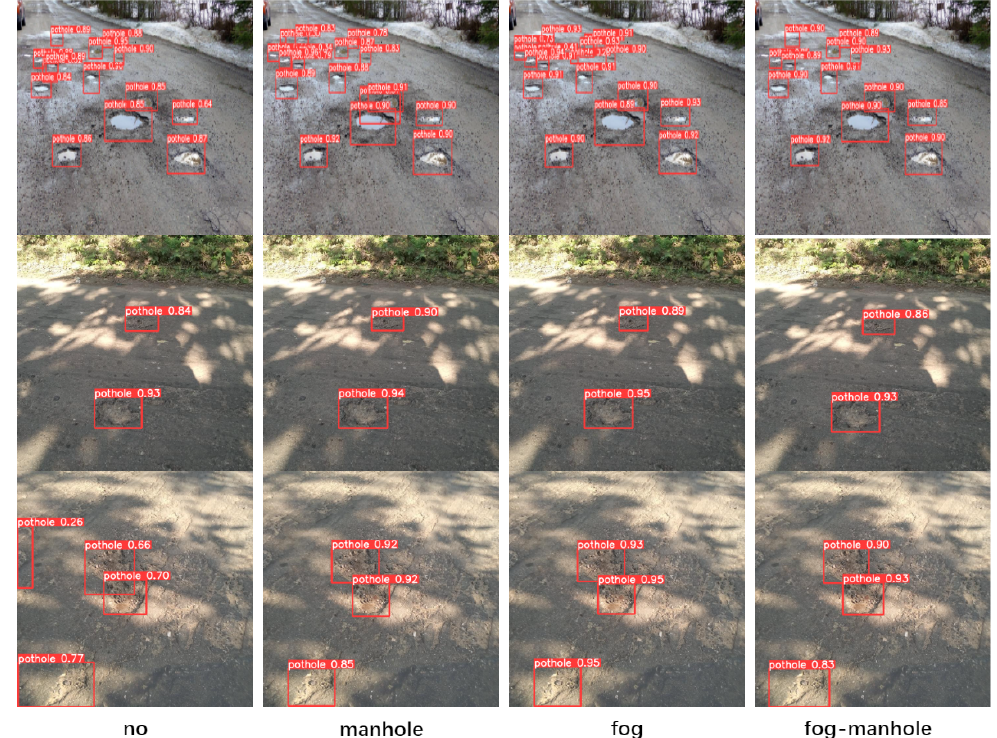
Figure 14. Visualization of images detected on the self-made dataset using different data augmenta- tion methods.